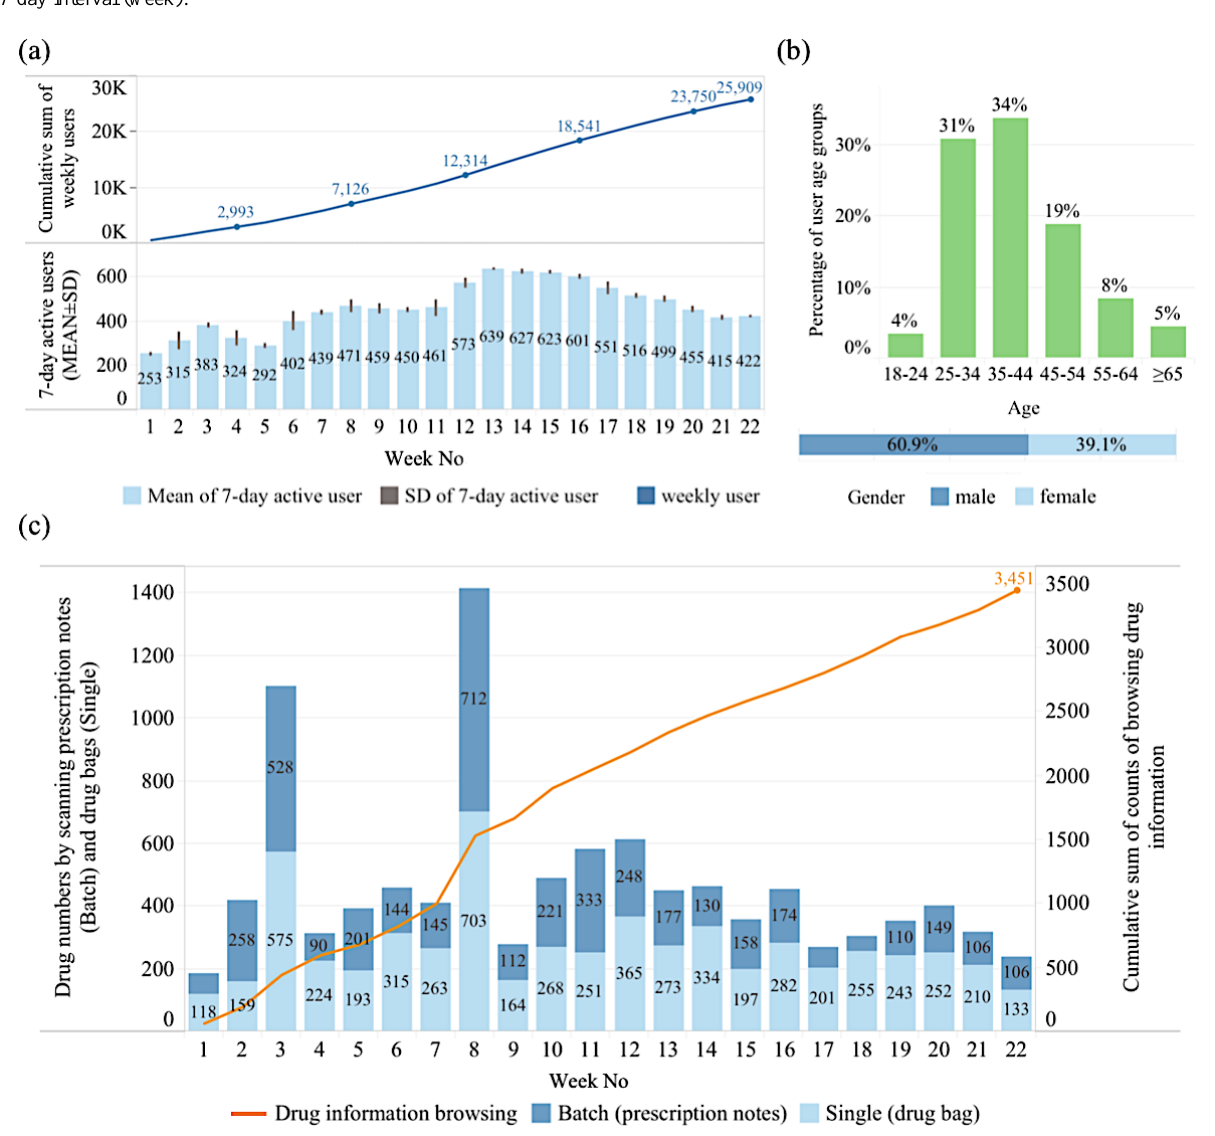
Figure 3. (a) The cumulative user number and average of 7-day active users, (b) age and gender demographics, and (c) the cumulative count of browsing drug information and the number of medication registration by scanning prescription notes or drug packaging during the 5-month pilot period illustrated by 7-day interval